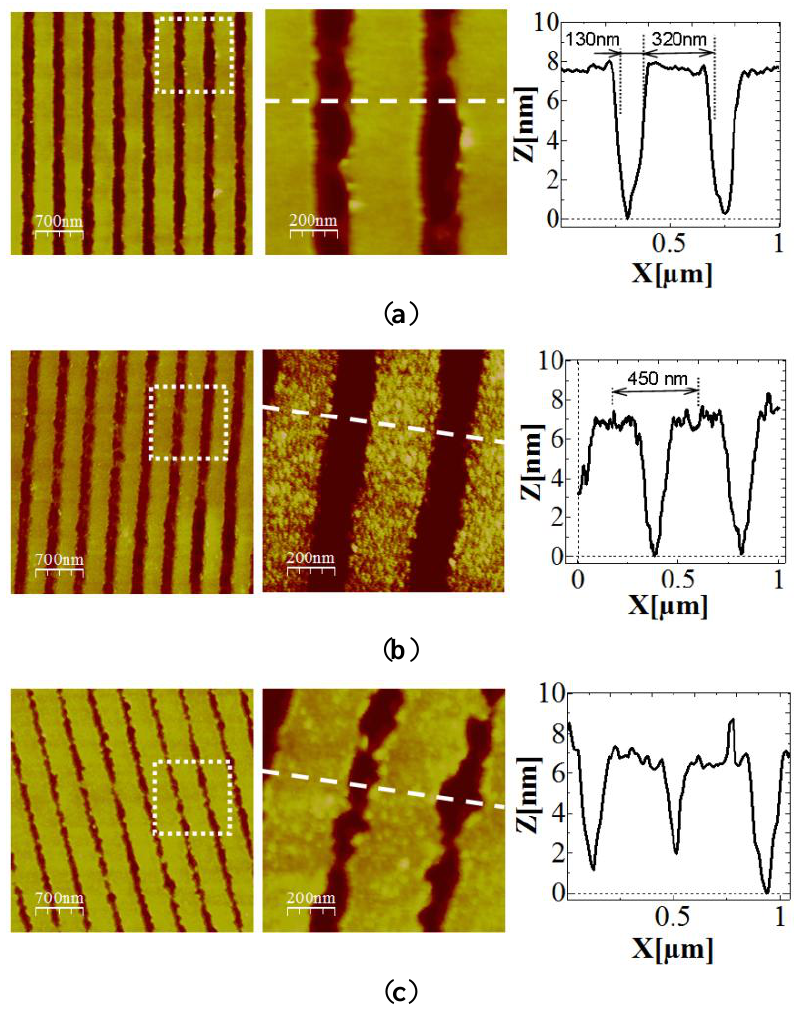
Figure 4. Atomic Force Microscopy (AFM) images of the grating chip ( a ) before, ( b ) after silicon nitride thin layer deposition and ( c ) after antibody functionalization. The grating structure is maintained after both the silicon nitride thin film and the organic layer deposition.